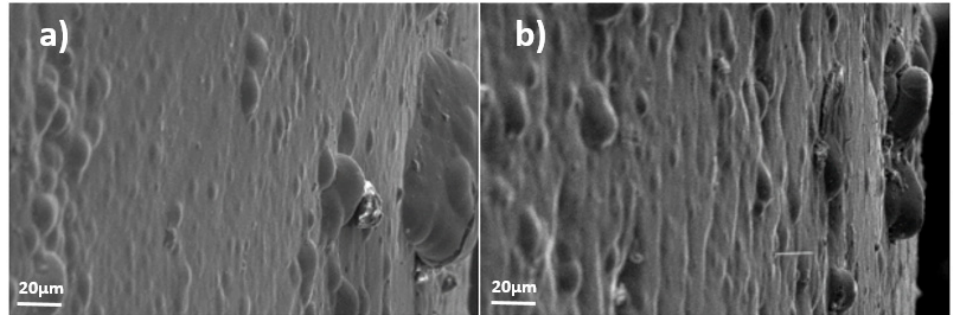
Figure 10. Example of surface evolution in yellow trivalent zinc electrolyte (sample 2) without stresses (R); ( a ) month 1, ( b ) month 3.